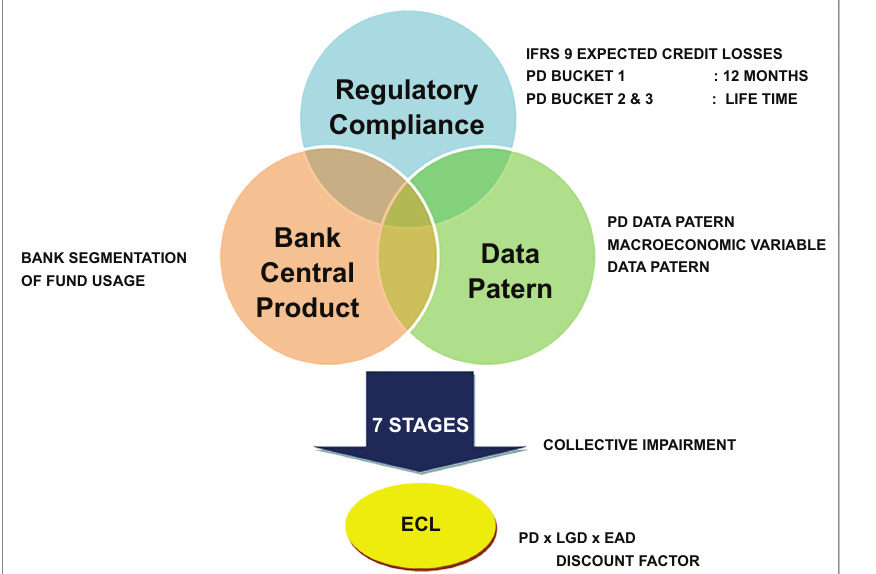
Figure 1. Impairment